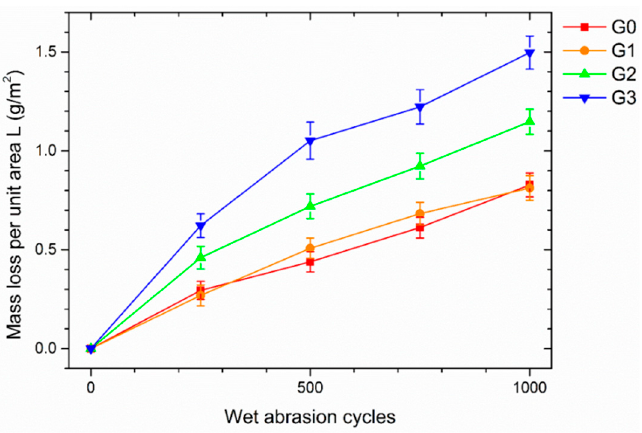
Figure 6. Loss in coatings mass per unit area, as a function of the abrasion cycles number.